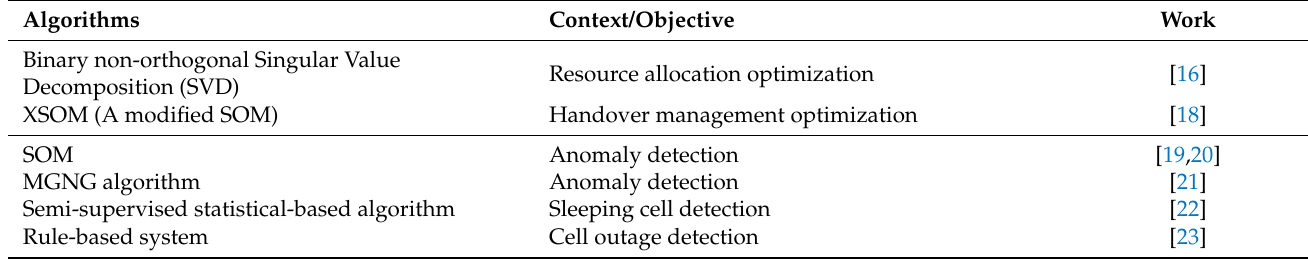
Table 1. Summary of the main works in the